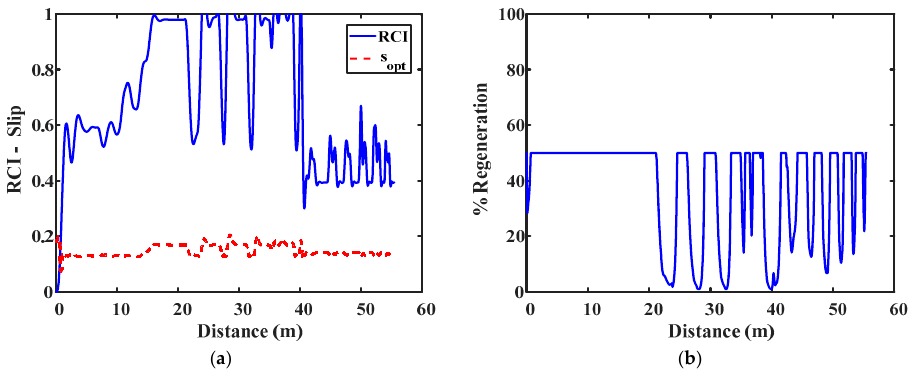
Figure 15. Estimation of road type and optimum slip ( a ) and regeneration rate ( b ). Energies 2017 , 10 , 1648